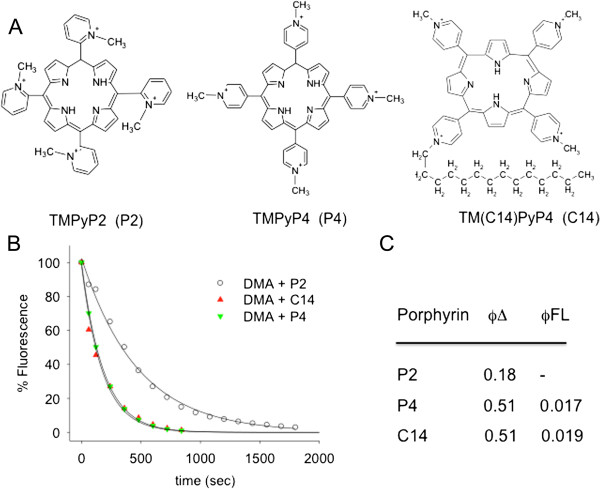
Structure and physical properties of the cationic porhyrins. (A) Structure of cationic porphyrins 5,10,15,20-tetra(N-methyl-4-pyridyl) porphin (TMPyP4 or P4); 5,10,15,20-tetra(N-methyl-2-pyridyl)porphin (TMPyP2 or P2) and 5,10,15-tri(N-methyl-4-pyridyl)20(N-C14H29)-4-pyridyl) porphin (C14); (B) DMA assay to determine the singlet oxygen quantum yield of porphyrins P2, P4 and C14. Full lines are the best-fit of experimental points to first order decay equation y = exp(-kt). Irradiation was performed with 60 mW lamp. Fluorescence quantum yield data are from [34]; (C) Singlet oxygen and fluorescence quantum yield values.